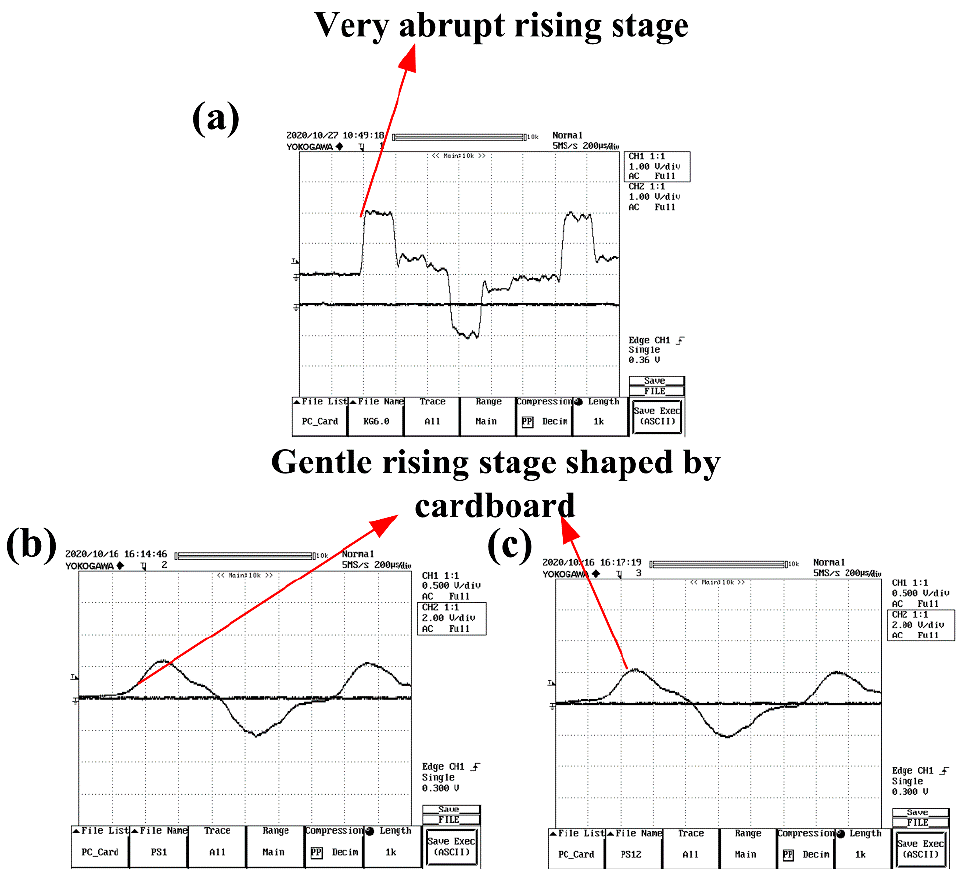
Figure 7. The incident stress wave patterns with and without cardboard as pulse shaper. ( a ) Very abrupt rising stage without cardboard, ( b ) Gentle rising stage shaped by cardboard, ( c ) Cardboard exhibited good consistent.